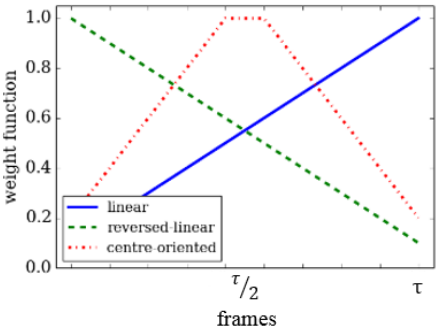
Figure 3. Fuzzy weight functions based weighted depth motion maps (DMMs).